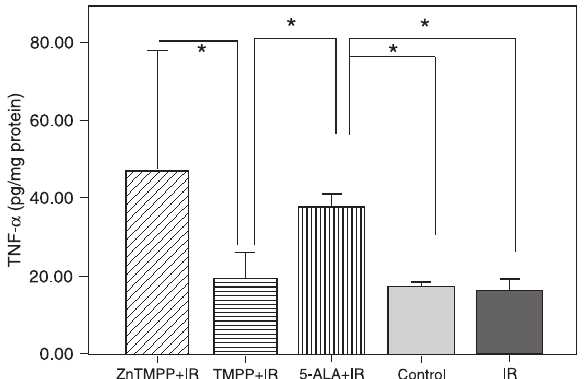
Figure 3. TNF-α level in tumor homogenates after photodynamic therapy applied to control, irradiated (IR), 5-ALA+IR , TMPP+IR and ZnTMPP+IR groups. TNF-α = tumor necrosis factor alpha; 5-ALA = 5-aminolevulinic acid; TMPP = 5,10,15,20-tetrakis(4- methoxyphenyl)-porphyrin; ZnTMPP = TMPP zinc compound. Statistical analysis was done by the Mann-Whitney U-test and by the Kruskal-Wallis test. *P <